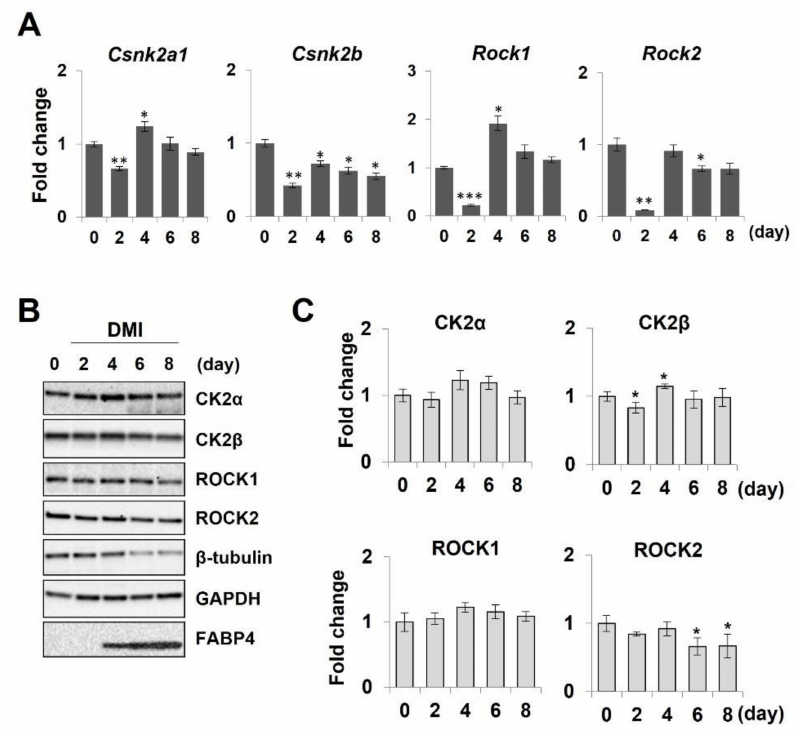
Figure 8. mRNA and protein expression levels of ROCKs and CK2 during the adipogenesis of 3T3-L1 cells. Differentiating 3T3-L1 cells were harvested on various time points (days 0, 2, 4, 6, and 8). ( A ) mRNA expression levels of Rock1 , Rock2 , Cskn2a1 , and Cskn2b were assessed by qRT-PCR. * p < 0.05; ** p < 0.01; *** p < 0.005 vs. day 0. ( B ) Protein expression levels of ROCK1, ROCK2, CK2 α , and CK2 β were visualized by immunoblot. FABP-4 was used as a differentiation marker. β -tubulin and GAPDH were used for loading controls. ( C ) The band intensity of CK2 subunits and ROCKs were quantified. * p < 0.05; ** p < 0.01; *** p < 0.005 vs. day